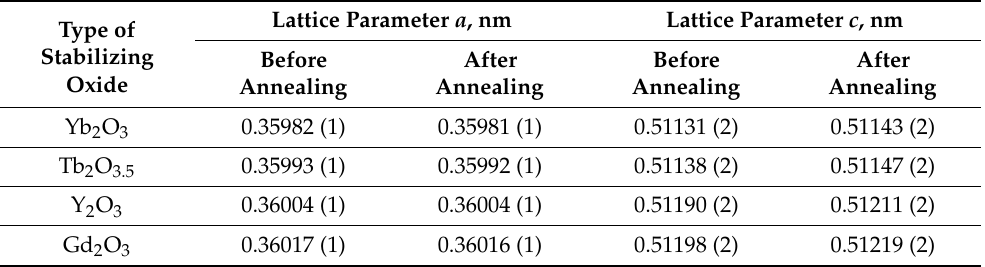
Table 3. Lattice parameters of the cubic phase before and after crystal annealing.